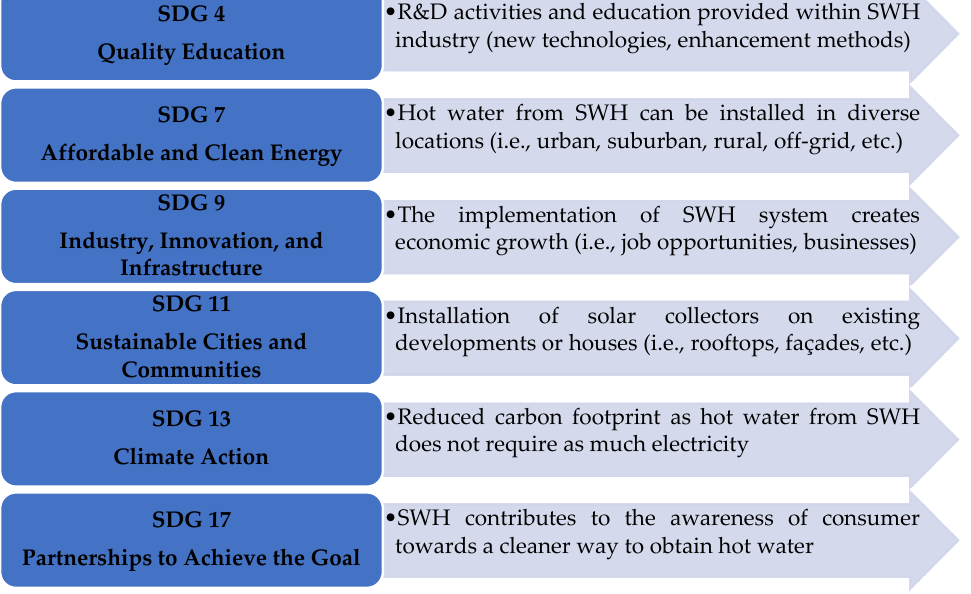
Figure 3. The impacts of SWH technologies on SDGs [23].